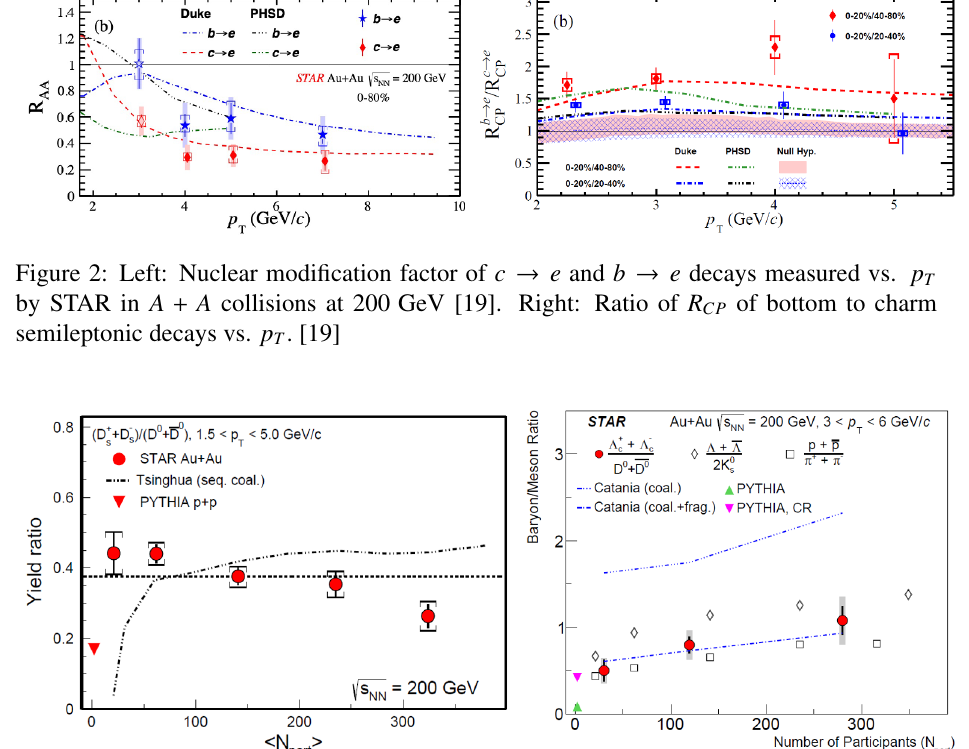
Figure 3: Left: Ratio of ( D + 200 GeV. Right: Ratio of ( Λ +